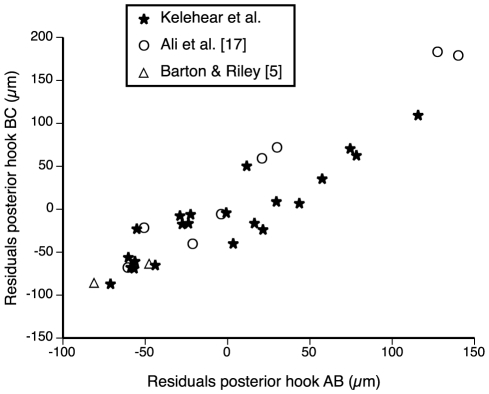
Barb length (AB) versus overall length (BC) of posterior hooks of Raillietiella frenatus from the current study compared to the literature.Kelehear et al. (2011, current study) measured R. frenatus from Rhinella marina and Hemidactylus frenatus; Ali et al. (1981) measured R. frenatus from H. frenatus; and Barton and Riley (2004) measured “R. indica” from R. marina. All measurements corrected for pentastome body size by calculating residual scores from a linear regression of hook measurements against pentastome body size.